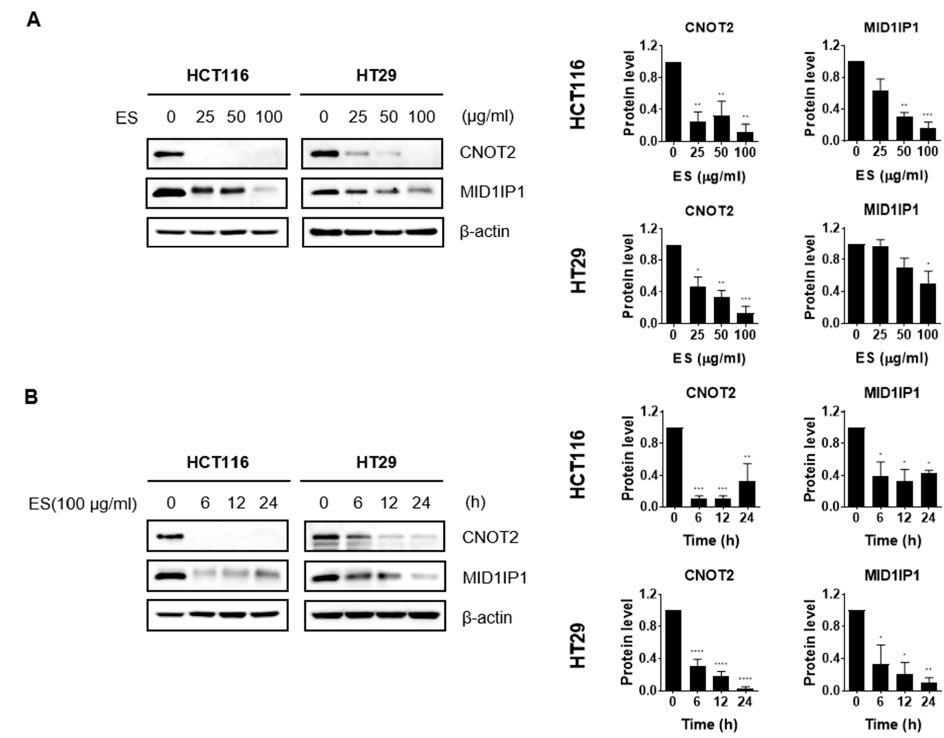
Figure 3. Effect of ES oncogenes in colon cancer cells. ( A ) The colon cancer cells were treated with each concentration (0, 25, 50, and 100 µg/mL) of ES. ( B ) The cells were treated with ES 100 µg/mL at different times (0, 6, 12, and 24 h). Using Image J, graphs were created that compare the expression levels of the housekeeper β -actin and each primary antibody. These results suggest that ES inhibits the expression of oncogenes, including CNOT2 and MID1IP1, in colon cancer cells. All data are pre- sented as the mean ± SEM. n = 3–4. * p < 0.05, ** p < 0.005 and *** p < 0.001, **** p < 0.0001 with the control group.